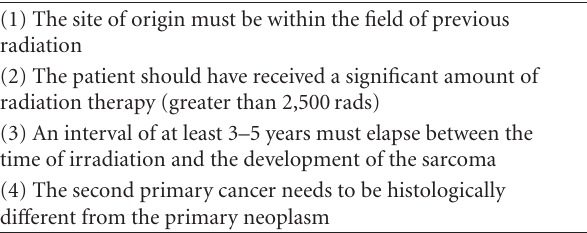
Table 3: Criteria for radiation-induced